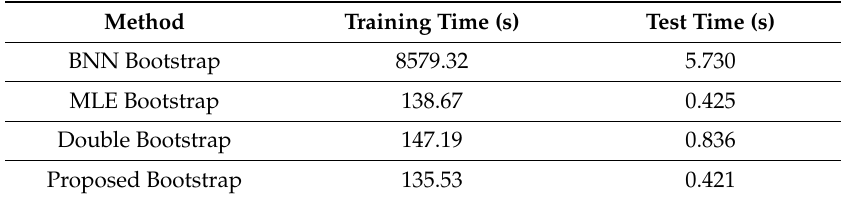
Table 3. The average training time and test time